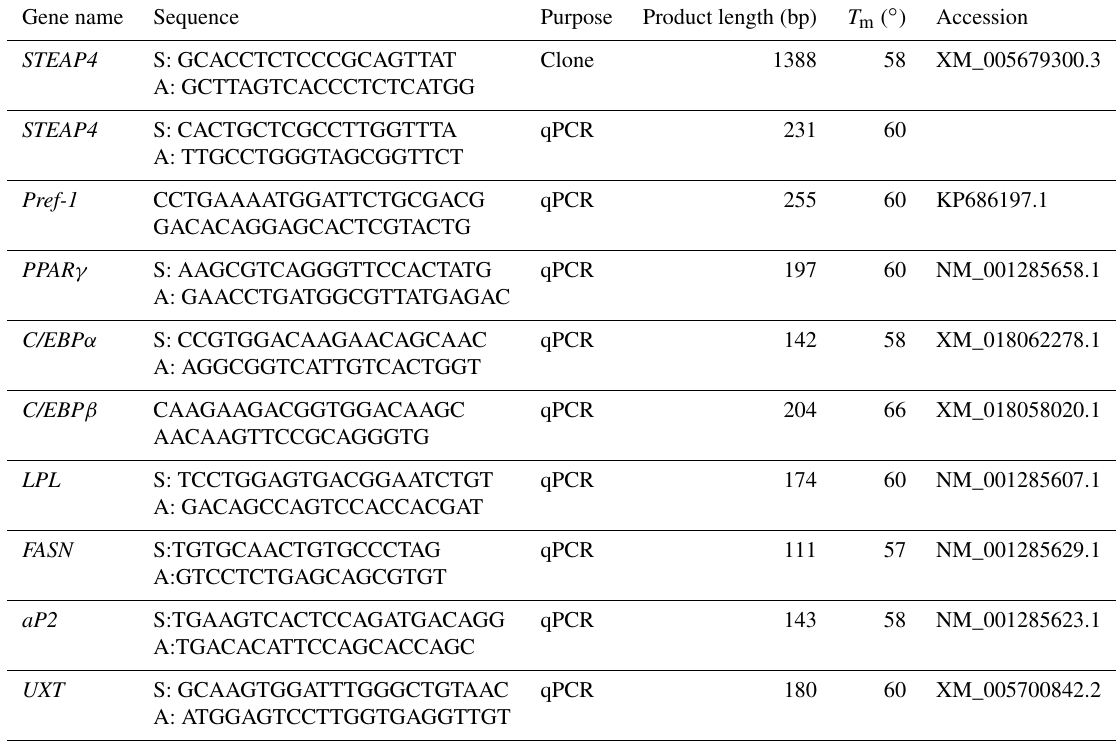
Table 1. Primer information for PCR and qPCR.